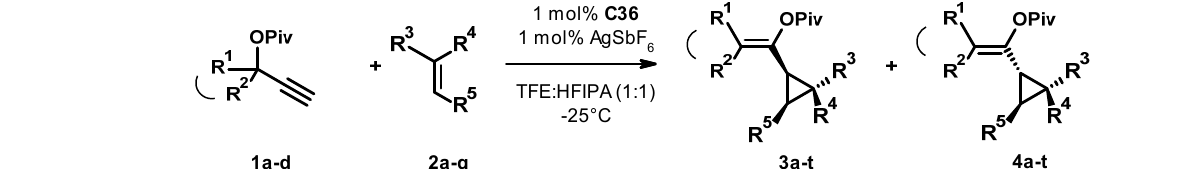
Table 5. Scope and limitation of the asymmetric cyclopropanation using the optimized conditions.